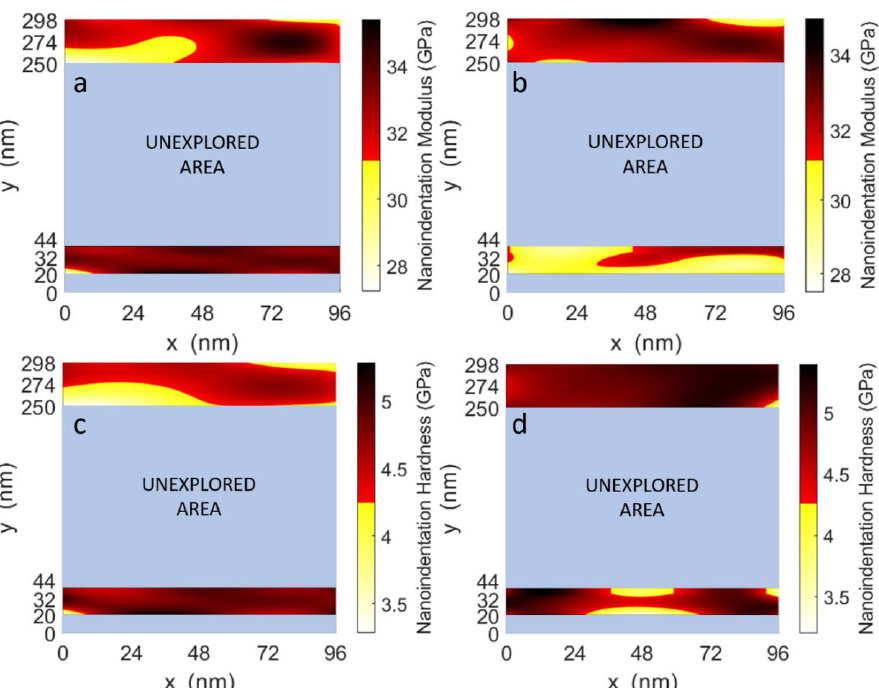
Figure A1. Representative color maps of the micromechanical properties obtained for orifice samples characterized by a diameter of 25 mm. ( a , b ) represent the distribution of the nanoindentation modulus obtained for the old deposition process and the new deposition process, respectively. ( c , d ) Represent the distribution of the nanoindentation hardness obtained for the old deposition process and the new deposition process, respectively.